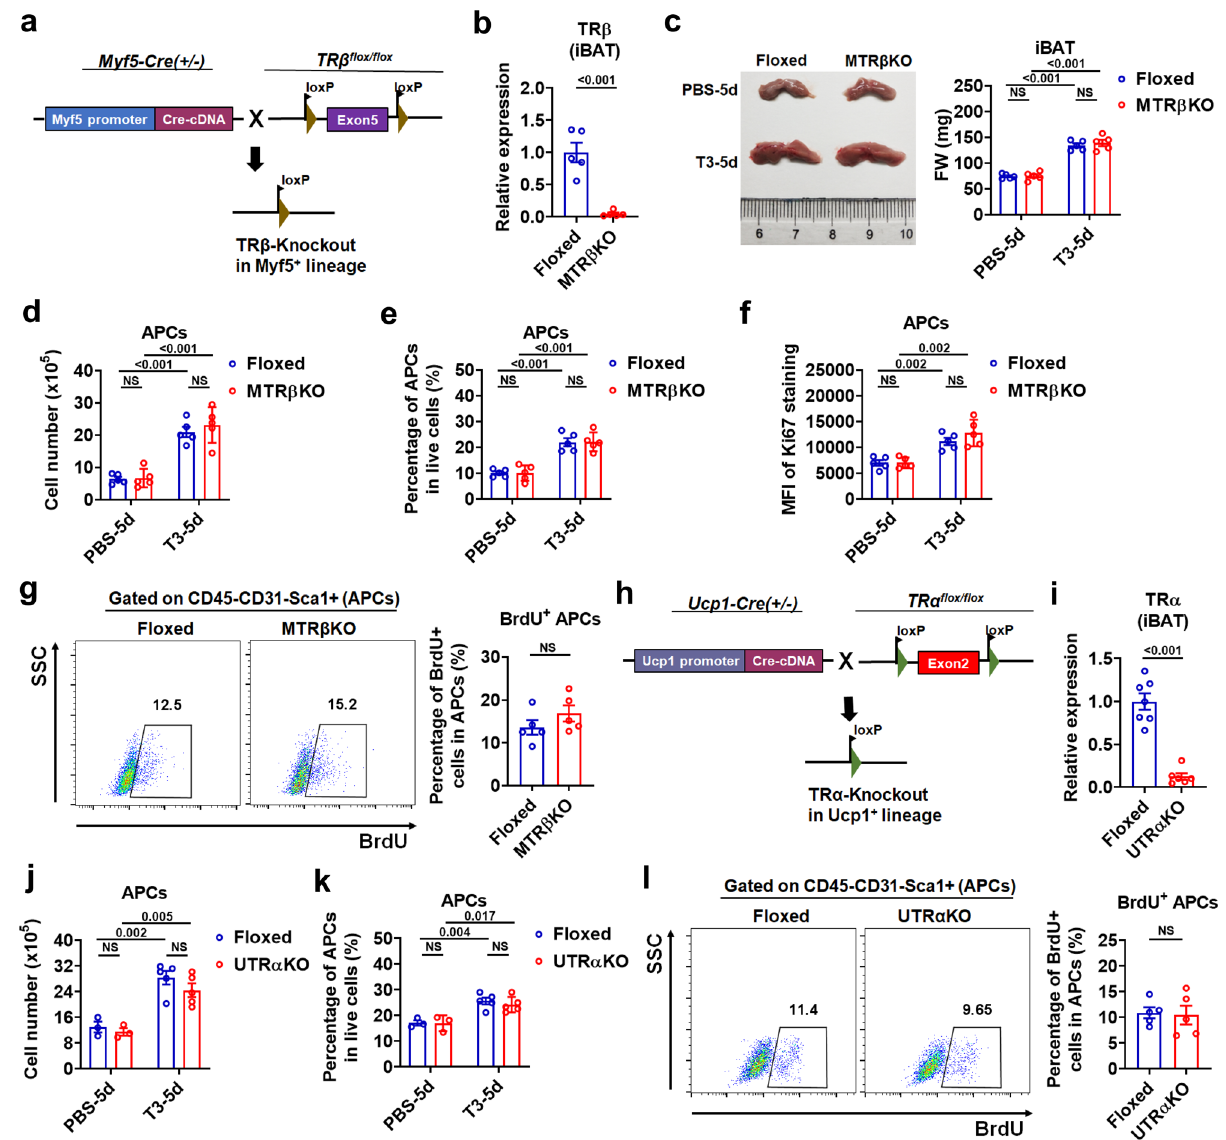
Fig. 4 Deletion of TR β by Myf5-cre or TR α by UCP1-Cre barely affects APC proliferation in iBAT. a Breeding scheme for generating MTR β KO mice. b Relative TR β mRNA levels in iBAT depots of TR β Floxed (Floxed) and MTR β KO mice ( n = 5). c Representative photograph (left) and FW of iBAT (right) of Floxed and MTR β KO mice with daily PBS or 0.5X standard dose of T3 injection for 5 d ( n = 5). d , e Number of APCs in iBAT per mouse ( d , n = 5) and percentage of APCs in live SVF cells of iBAT ( e , n = 5) from Floxed and MTR β KO mice with daily PBS or 0.5X standard dose of T3 injection for 5 d. f MFI of Ki67 staining in APCs of Floxed and MTR β KO mice with daily PBS or 0.5X standard dose of T3 injection for 5 d ( n = 5). g FACS plot and quanti fi cation of the BrdU + APCs in iBAT from Floxed and MTR β KO mice with daily PBS or 0.5X standard dose of T3 injection for 5 d ( n = 5). Cells were pre-gated on live CD45 − CD31 − Sca1 + cells. h Breeding scheme for generating UTR α KO mice. i Relative TR α mRNA levels in iBAT depots of TR α Floxed (Floxed) ( n = 7) and UTR α KO mice ( n = 6). j , k Number of APCs in iBAT per mouse ( j ) and percentage of APCs in live SVF cells of iBAT ( k ) from Floxed and UTR α KO mice with daily PBS ( n = 3) or 0.5X standard dose of T3 ( n = 5) injection for 5 d. l FACS plot and quanti fi cation of the BrdU + APCs in iBAT from Floxed and UTR α KO mice with daily T3 injection at 0.5X standard dose for 5 d ( n = 5). Cells were pre-gated on live CD45 − CD31 − Sca1 + cells. Means ± SEM are shown. P values were calculated by two-tailed unpaired Student ’ s t test for b – g , i – l . NS, not signi fi cant. Source data are provided as a Source Data fi